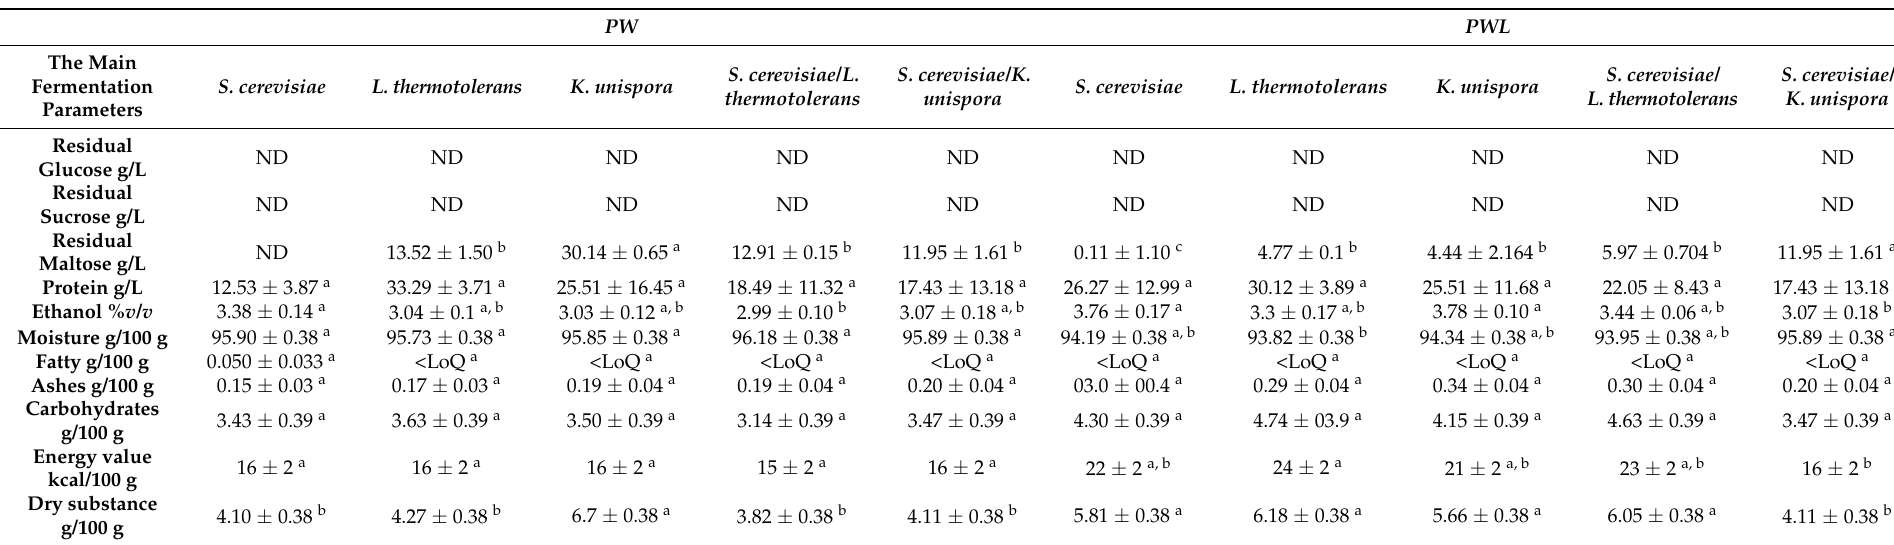
Table 1. The main analytical characters of final beer on PW (pils wort) and PWL (pils wort added with 20% HRL). Data are the means ± standard deviations. Data with different superscript letters ( a, b, c ) within each row between the fermentation trials tested on same wort (Duncan tests; p < 0.05). The initial composition of the sugars in pils wort were: Glucose 11.92 g/L; Sucrose 24.2 g/L; Maltose 74.73 g/L. Protein content: 12.02 g/L. The initial composition of the sugars in pils wort added with lentil were: Glucose 6.74 g/L; Sucrose 37.72 g/L; Maltose 84.70 g/L. Protein content: 26.39 g/L. %). ND: not detected. LoQ: limit of quantification (1 g/L). PW